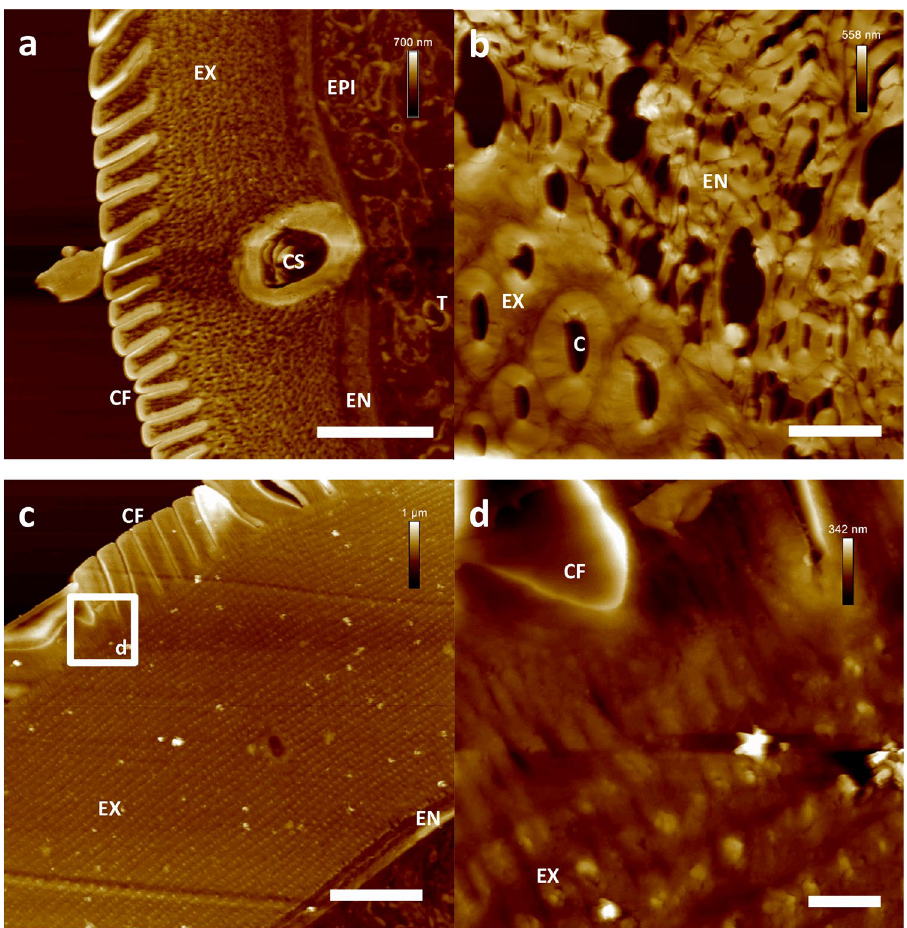
Figure 4. AFM-based ultrastructural analysis of the cuticle of hedgehog ticks ( Ixodes hexagonus ). Nanoscopic resolution on tissues from more complex organisms. ( a ) Cuticular detail of a starving nymph of I. hexagonus ( b ) Cuticular detail of a fully engorged adult individual of I. hexagonus ( c ) Cuticular detail of a starving adult individual ( d ) Higher resolution of the I. hexagonus cuticle. Scale bars ( a – c ) 10 µm, ( d ) 1 µm. C pore canal, CF cuticular folds, CS cuticular sensilla, EN endocuticle, EPI Epidermis, EX exocuticle, T single